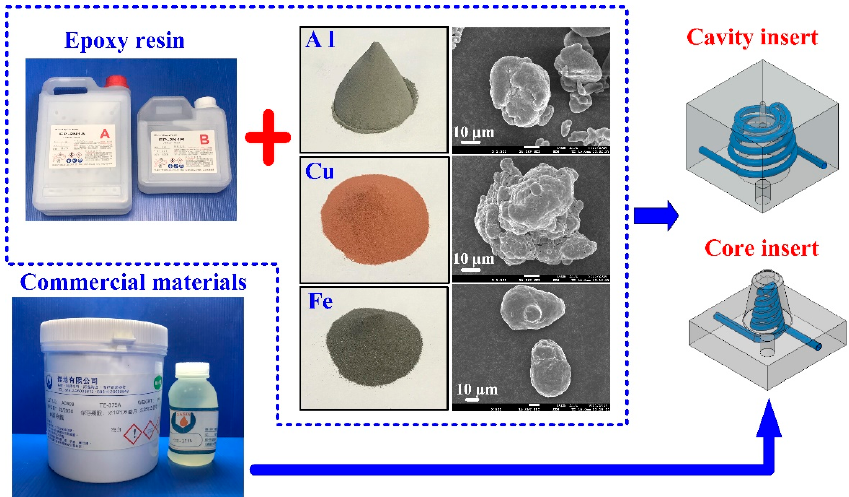
Figure 4. Three different kinds of fillers were added into the epoxy resin to make injection molds.